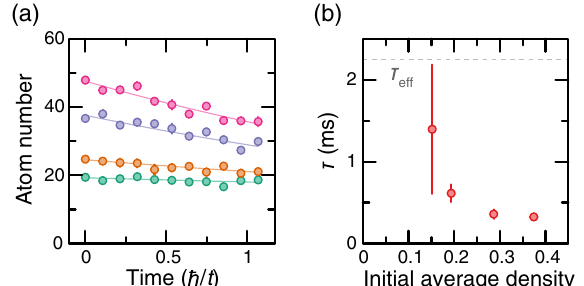
FIG. 9. Atomlossduringcharge-densitywavedynamics.(a)Atom number decay over the quenches shown in Fig. 5. Each color represents a set with a different initial density. Circles are measured data with error bars and lines are simple exponential decay fits. The dressing parameters are Ω ¼ 2 π × 6 . 99 ð 8 Þ MHz and Δ ¼ 2 π × 30 MHz. (b) Lifetime vs the initial average density of the charge-density wave as extracted from the data in (a). This behavior is in agreement with our observations shown in Fig. 3. Experimental error bars correspond to the standard error of the